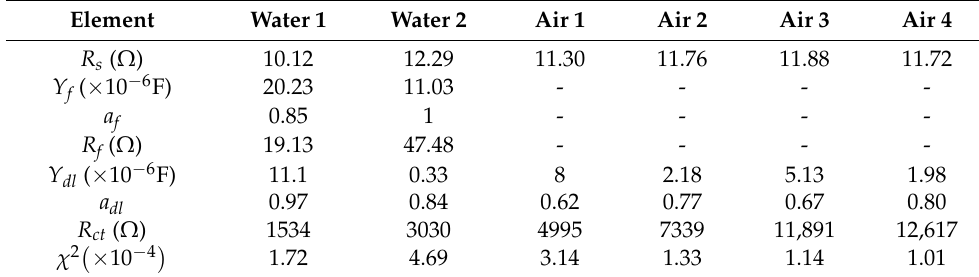
Table 3. Corrosion parameters of the quenched AA7075-T6 block.